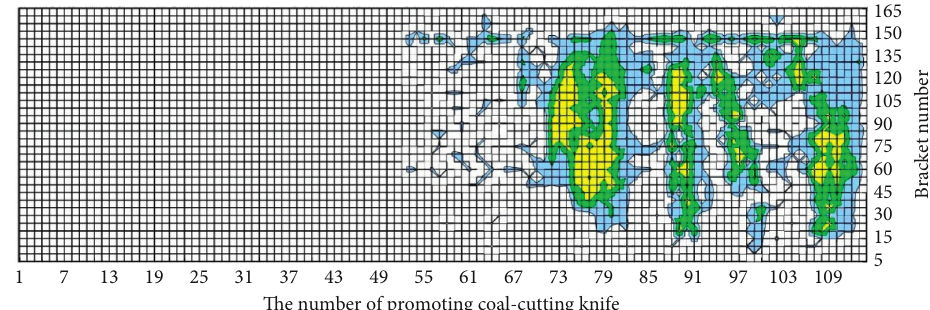
Figure 5: The distance and strength of first and periodic roof